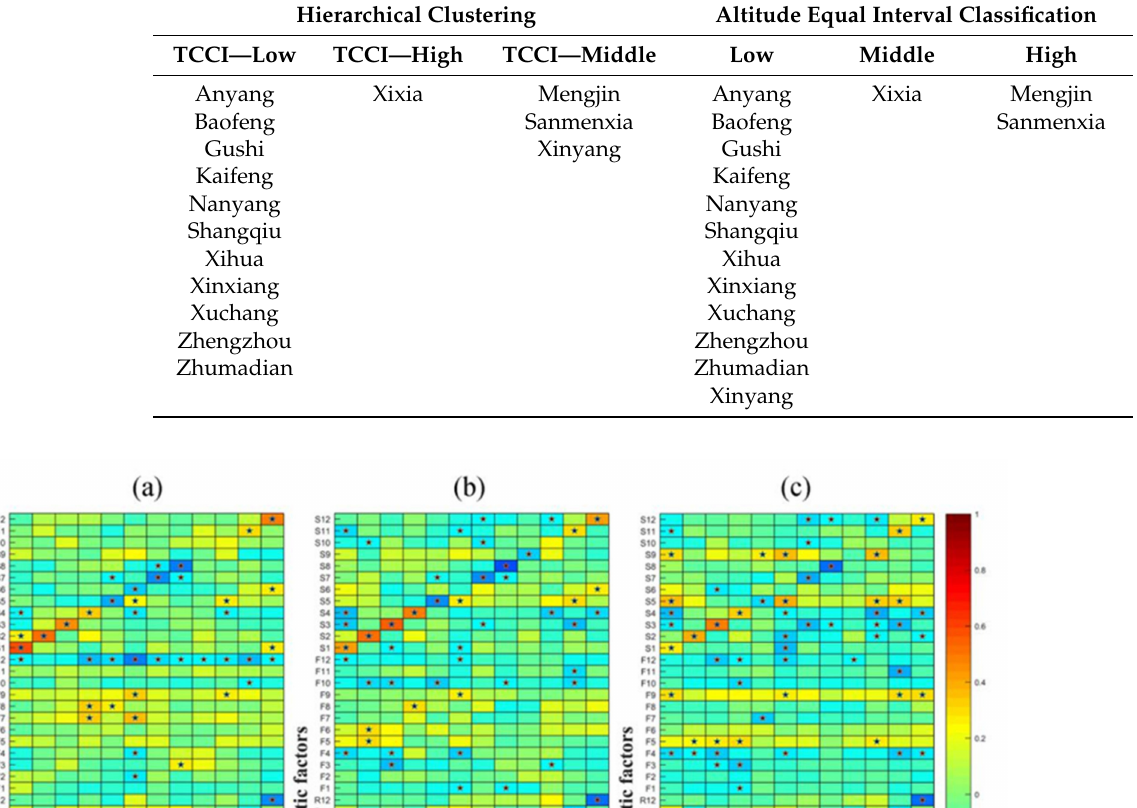
Table 2. Hierarchical clustering and altitude equal interval classification results of the TCCI of